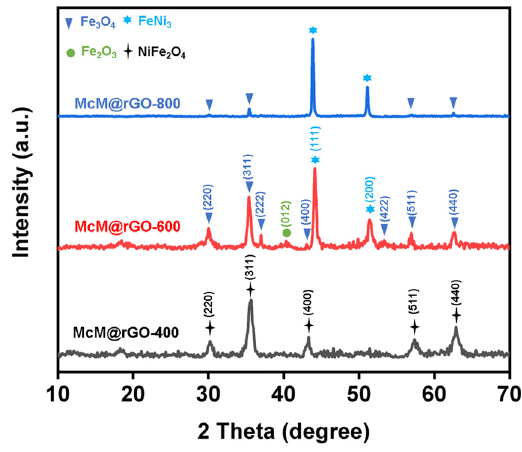
Figure 2: XRD patterns of McM@rGO synthesized at di ff erent